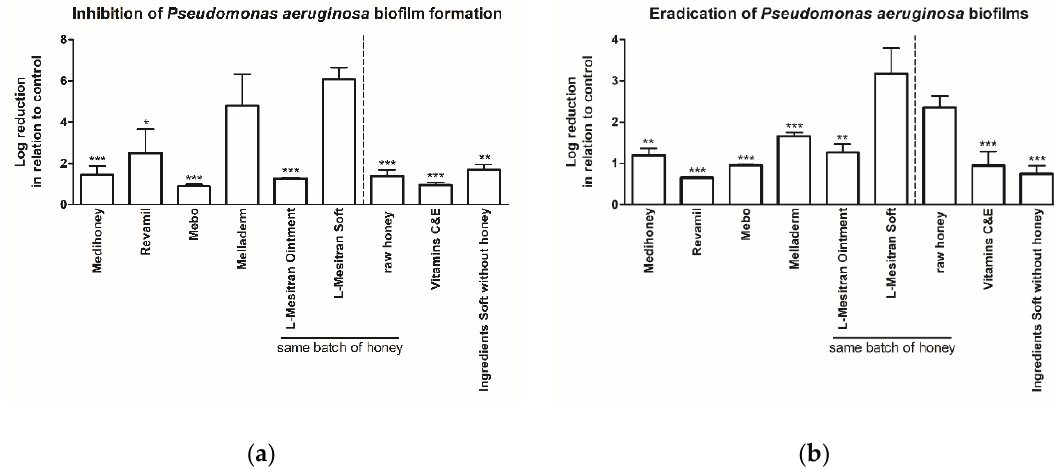
Figure 1. Antibiofilm activity of di ff erent natural products on Pseudomonas aeruginosa biofilms. Data are presented as mean log reduction ± standard deviation in relation to untreated control. ( a ) Inhibition of Pseudomonas aeruginosa biofilm formation. L-Mesitran Soft was significantly more e ff ective (*** p < 0.001) compared to all other products, except Melladerm (significances not added in the graph). Significant di ff erences with Melladerm are indicated by * above each column (* p < 0.05, ** p < 0.01, *** p < 0.001). No other significant di ff erences were observed. ( b ) Eradication of Pseudomonas aeruginosa biofilms. L-Mesitran Soft was significantly stronger (*** p < 0.001) compared to all other groups, except raw honey (significances not shown in the graph). Significant di ff erences with raw honey are indicated by * above each column (** p < 0.01, *** p < 0.001). Melladerm was significantly higher than Revamil and Ingredients Soft without honey groups (* p < 0.05). No other significant di ff erences were